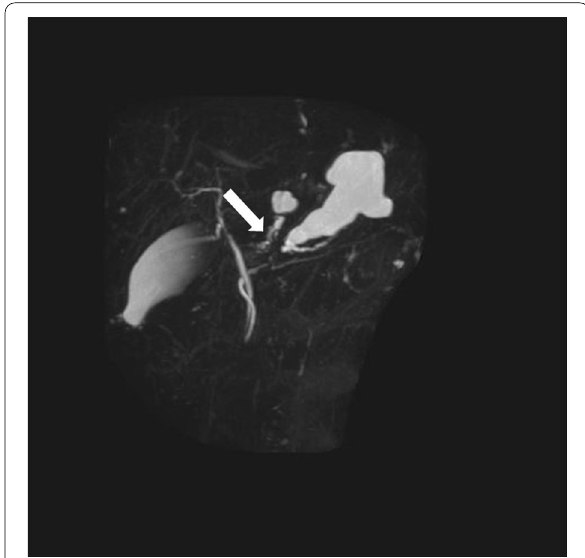
Fig. 2 MRCP image before neoadjuvant chemotherapy. A cystic lesion protruding outside the ventral pancreas, continuous with the bifurcated main pancreatic duct. The nodular lesion was connected to the pancreatic duct (white arrow)